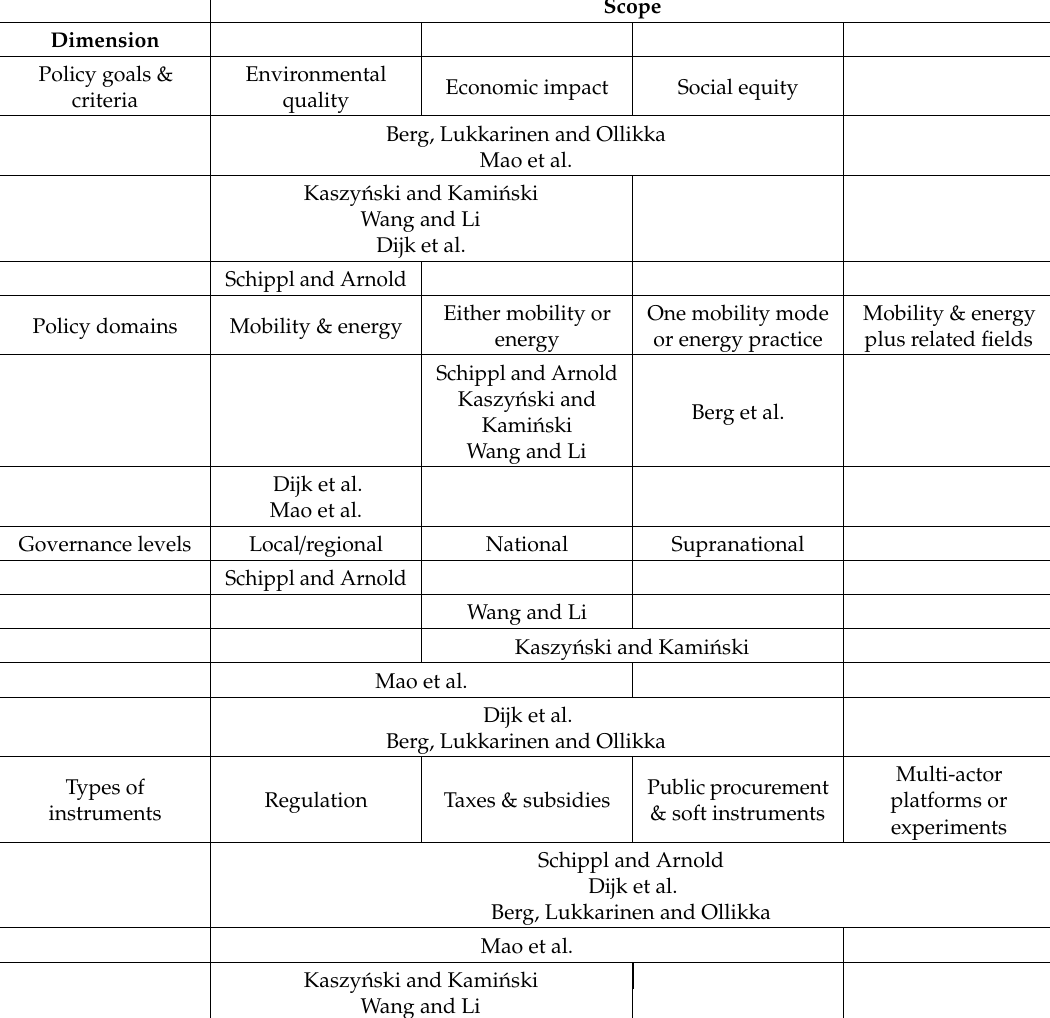
Table 1. Mapping the six articles regarding scope in four key dimensions of policy coherence in low carbon